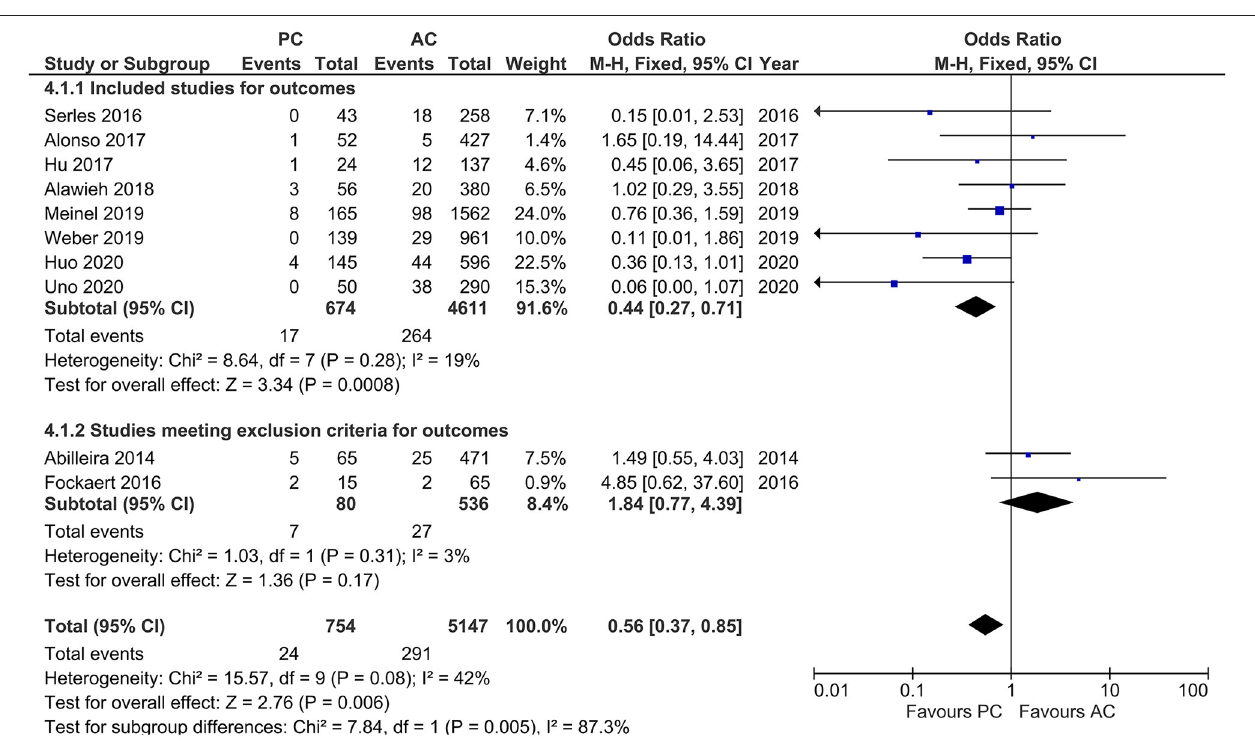
FIGURE 9 | Forest plot comparing “symptomatic intracranial hemorrhage” in patients with large vessel occlusion (LVO) in the posterior circulation (PC) vs. anterior circulation (AC) who were treated with endovascular mechanical thrombectomy. Two studies with < 20 PCLVO patients and/or patient recruitment primarily until 2012 were excluded from subgroup analysis. Chi 2 , chi-square statistic; CI, confidence interval; df, degrees of freedom; I 2 , I -square heterogeneity statistic; M-H, Mantel–Haenszel statistic; P , p -value; Z , Z